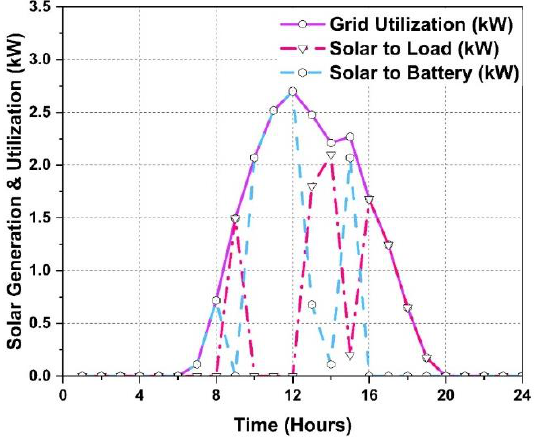
Figure 10. Battery states of charge (SoCs) in on−grid .